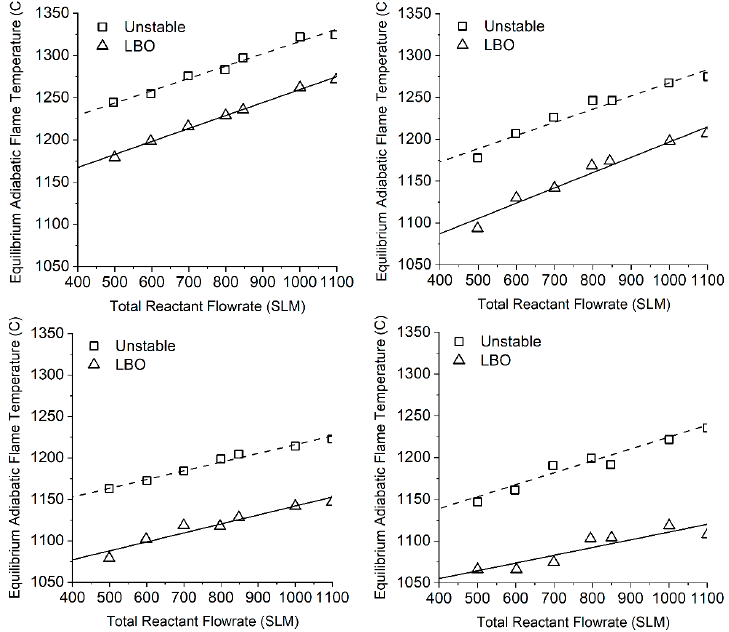
Figure 22. Change of adiabatic flame temperature during flame blowout .